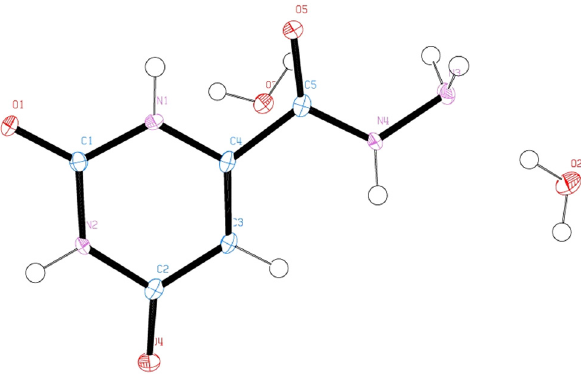
Figure 1: Crystal structure of compound 2